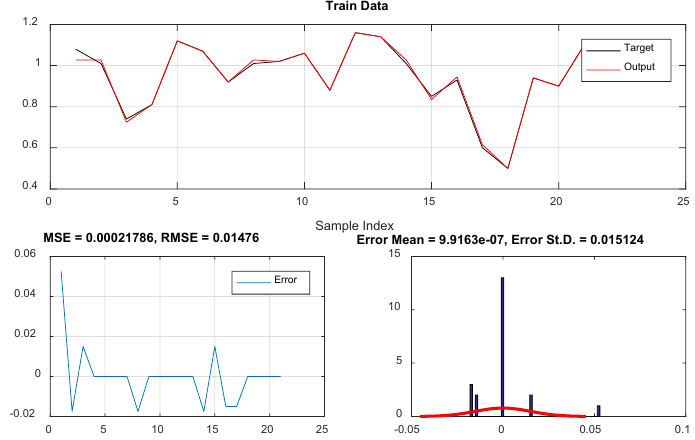
Figure 16. Error and training behavior of ANFIS-PSO model .